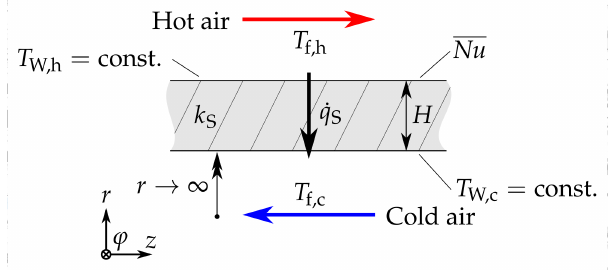
Figure 5. Comparison between nominal test plan and realized test plan for Reynolds number Re ϕ and mass flow C w